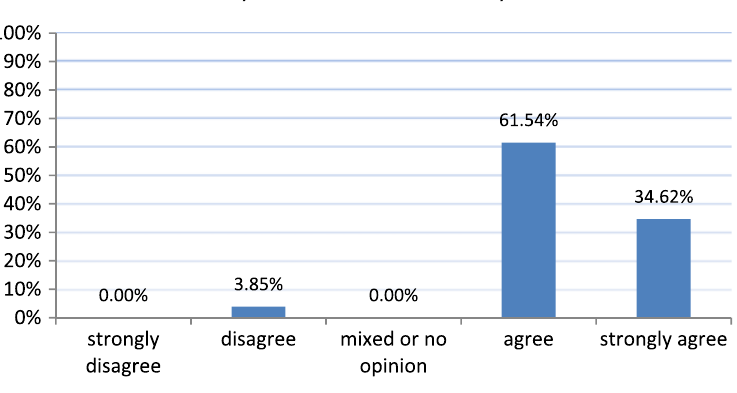
Figure 2. The university actively and consistently reaches out to the wider world beyond